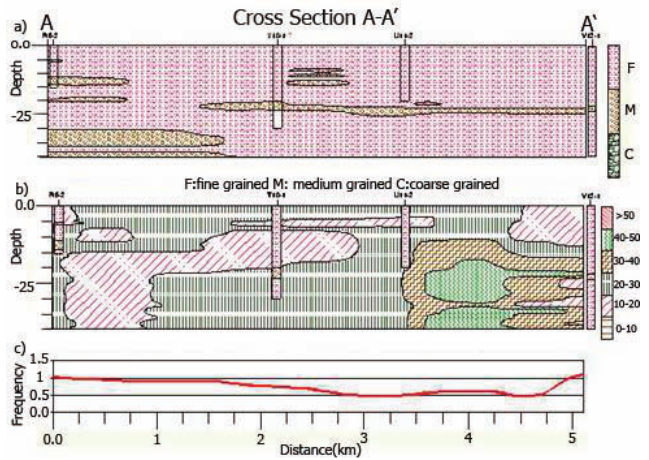
Figure 7. B-B` cross-section. Variations in the soil texture (a) N-SPT (b), and predominant frequency (c).